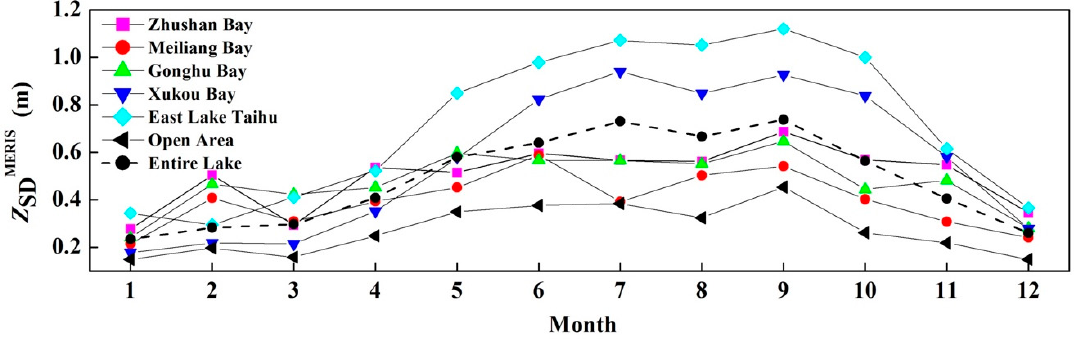
Figure 12. Phenological variation of Z SD in each region of Lake Taihu.